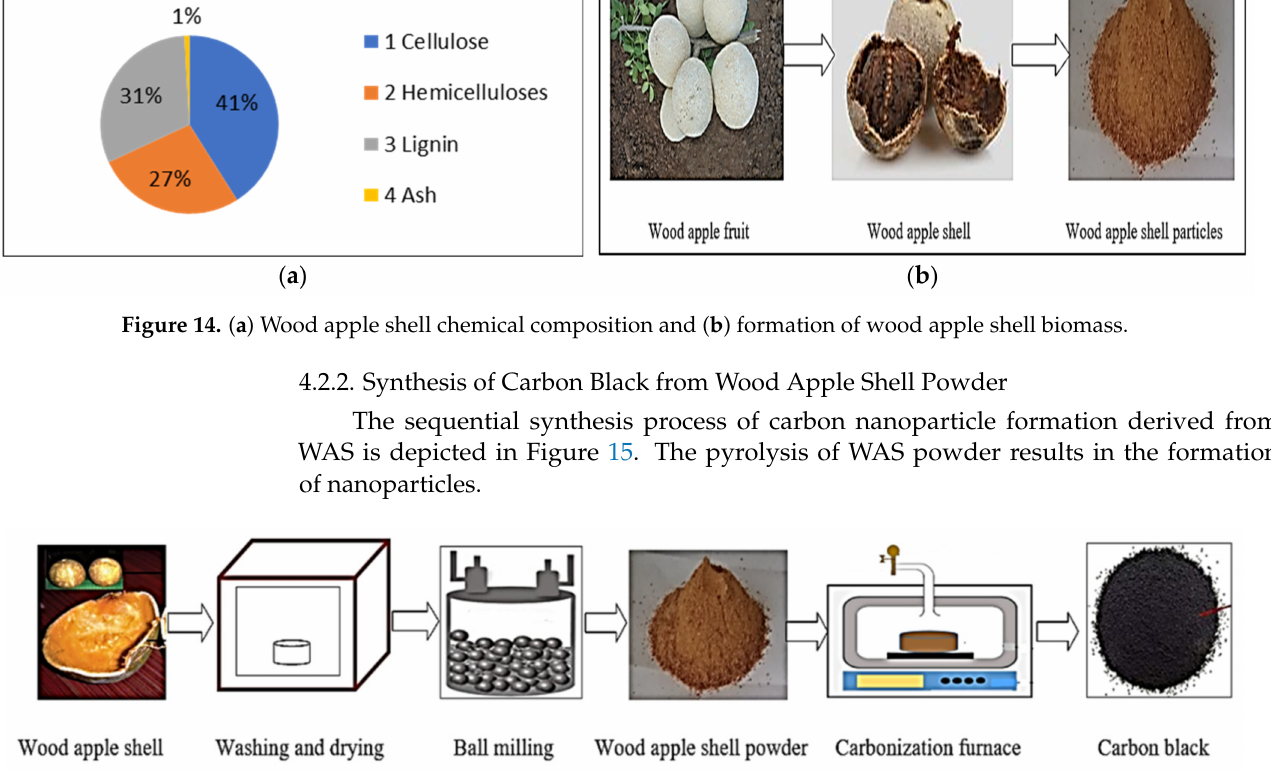
Figure 15. Synthesis process of carbon black from wood apple shell